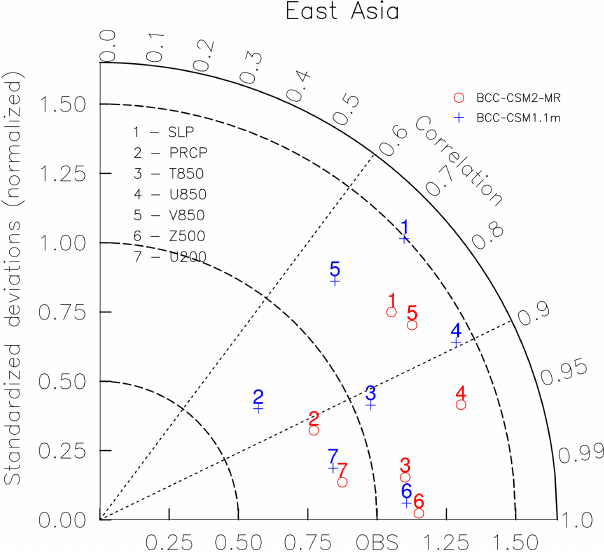
Figure 17. Same as in Fig. 8, but for the domain covering East Asia (20–50 ◦ N, 100–140 ◦